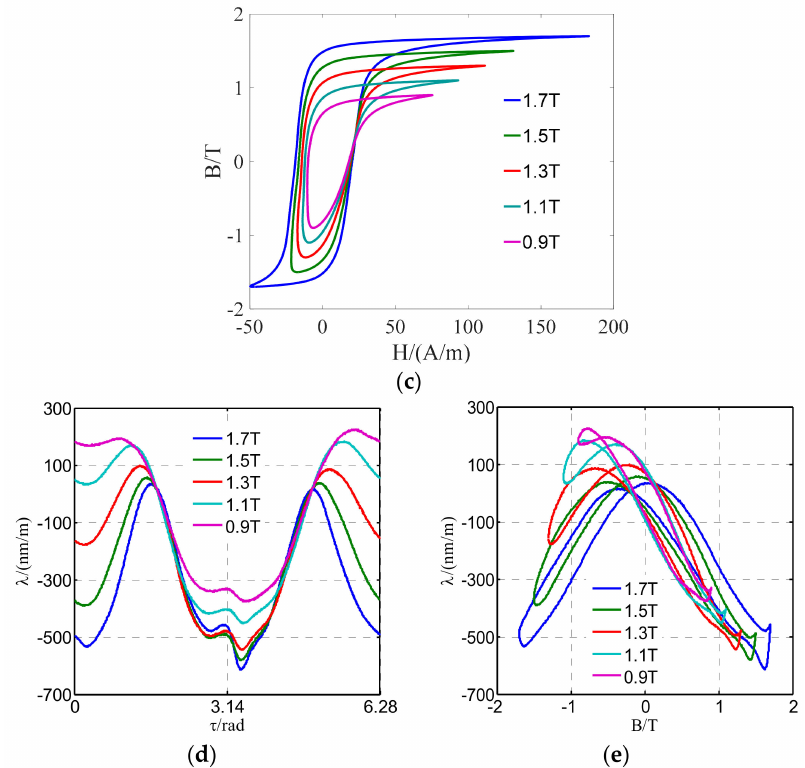
Figure 2. Measured results under DC-biased magnetization along the rolling direction ( H dc = 12 A / m, B m = 0.9 T, 1.1 T, 1.3 T, 1.5 T, 1.7 T): ( a ) Waveforms of magnetic flux density; ( b ) waveforms of the measured magnetic intensity; ( c ) magnetic hysteresis loops; ( d ) waveforms of the measured magnetostrictive strain; ( e ) measured magnetostriction loops (butterfly curves).